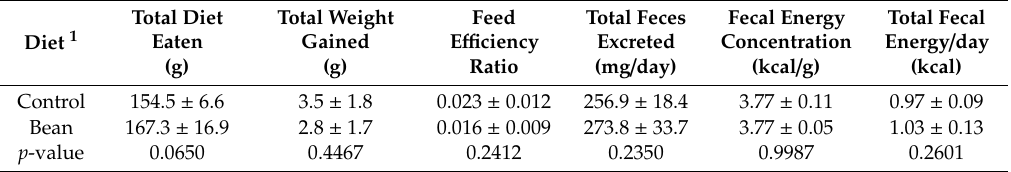
Table 3. E ff ect of white kidney bean on food e ffi ciency ratio and fecal energy (Experiment 2).